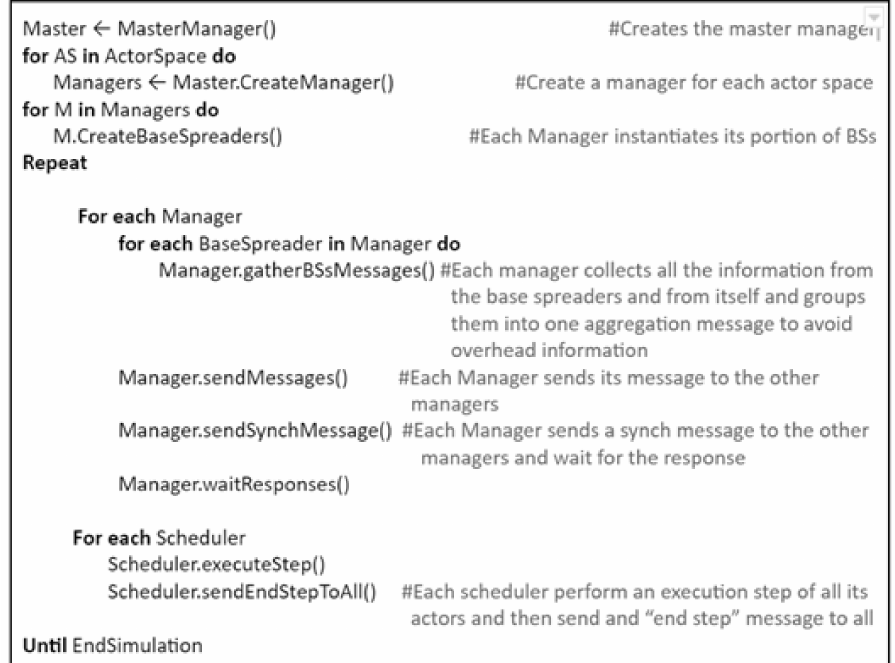
Figure 4. The simulation process